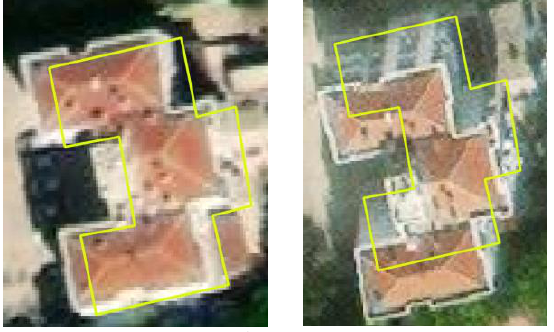
Figure 12. One example from False positive result. Yellow: Vector dataset. The building height is 24 meters.